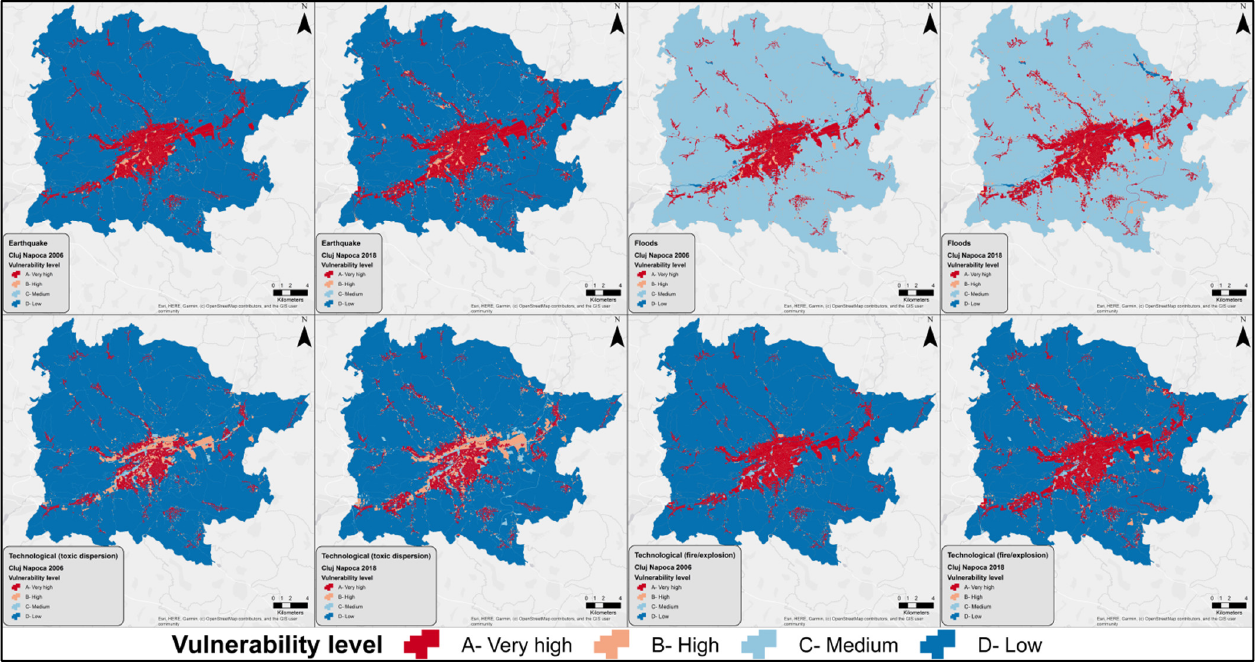
Figure 3. Visualization of temporal and spatial variation in vulnerability level for Cluj-Napoca FUA.